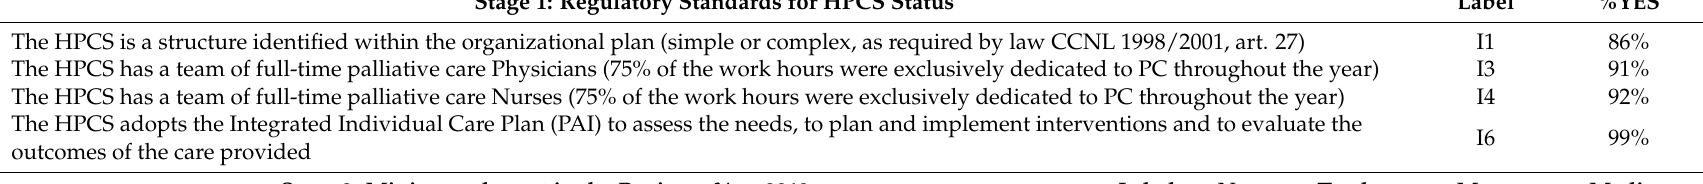
Table 1. Main data (N = 118 registered HPCSs, eligible for the “Best Practice